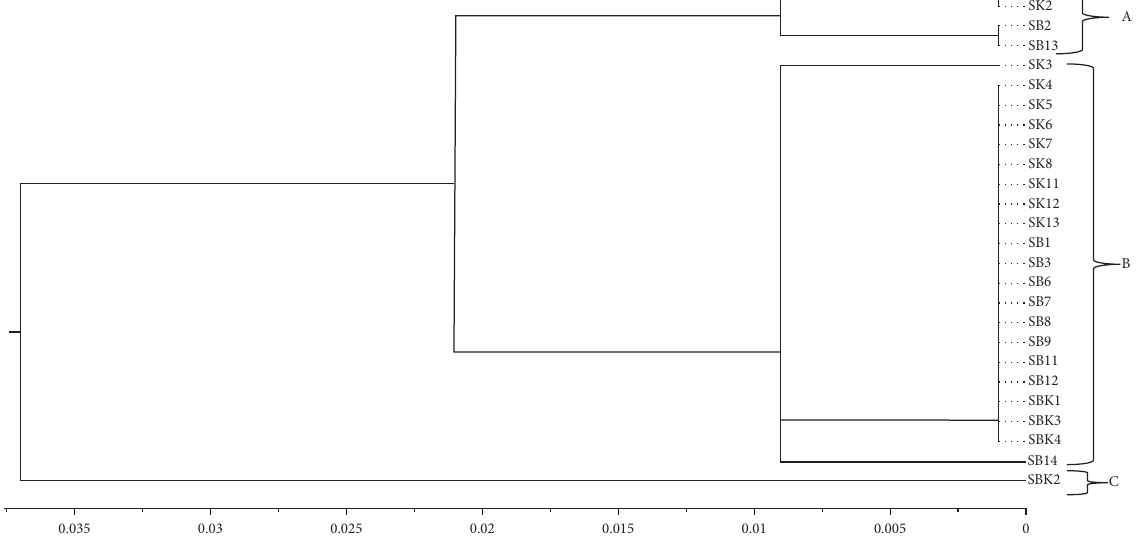
Figure 4: Dendrogram illustrating coefficient similarity among in vitro regenerated plants and mother plants (SB6 and SBK4) of passion fruit KPF 4 by UPMGA cluster analysis of SRAP data set showing a genetic relationship. SK1, SK2, SK3, SK4, and SK5 represent plants in vitro micropropagated on MS supplemented with 1 mg · L − 1 KIN. SK6, SK7, and SK8 represent plants in vitro micropropagated on MS supplemented with 2mg · L − 1 KIN. SK11, SK12, and SK13 represent plants in vitro micropropagated on MS supplemented with 3mg · L − 1 KIN. SB1, SB2, and SB3 represent plants in vitro regenerated on MS supplemented with 1 mg · L − 1 BAP. SB6 is a mother plant; SB7, SB8, and SB9 represent plants in vitro regenerated on MS supplemented with 2mg · L − 1 BAP. SB11, SB12, SB13, and SB14 represent plants in vitro micropropagated on MS supplemented with 3 mg · L − 1 BAP. SBK 1, SBK2, and SBK3 represent plants in vitro regenerated on MS sup- plemented with 2mg · L − 1 BAP and 0.5 mg · L − 1 KIN while SBK4 represents the mother plant.